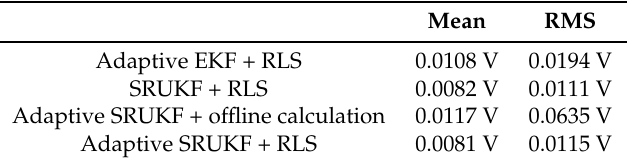
Table 1. Statistics of the terminal voltage simulation errors.